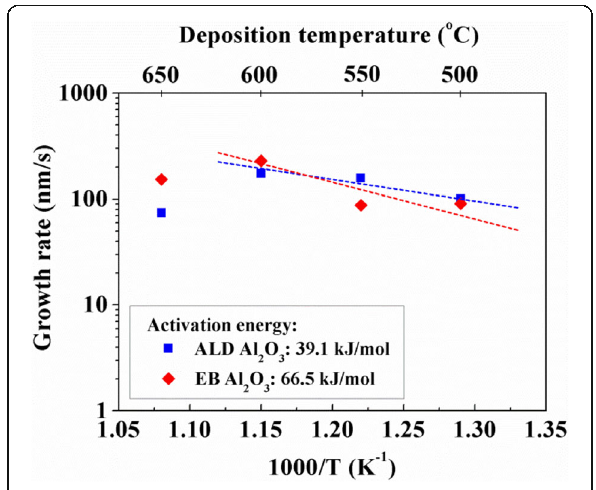
Fig. 7 Variation of the growth rate on ALD and EB Al 2 O 3 buffer layers as a function of the deposition temperature. The activation energies were calculated from a linear interpolation of the